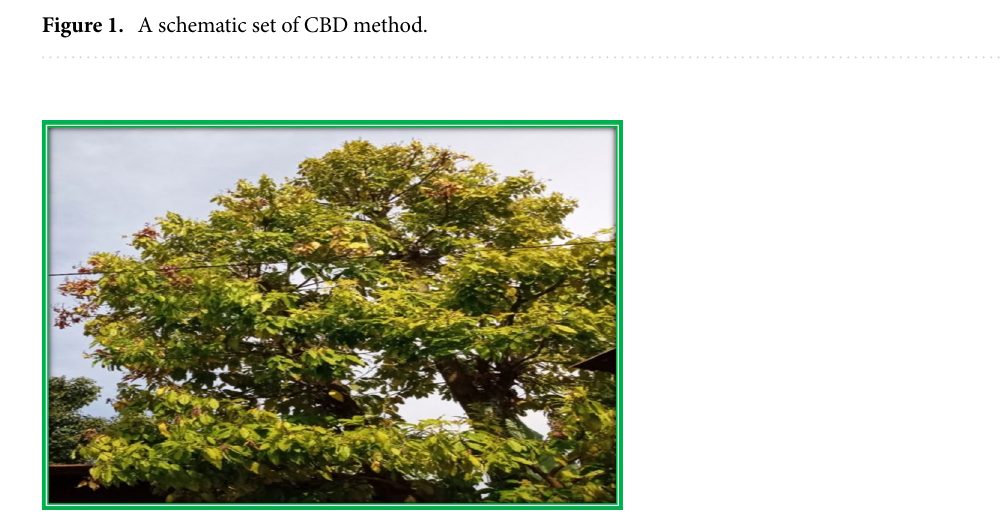
Figure 2. Avocado ( Glycosmis cochinchinensis ) Leaf extracts plant and its fruit taken from local area of Dambi Dollo Town, Oromia,